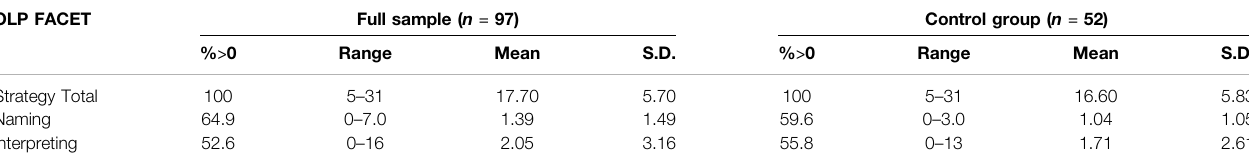
TABLE 3 | Descriptive